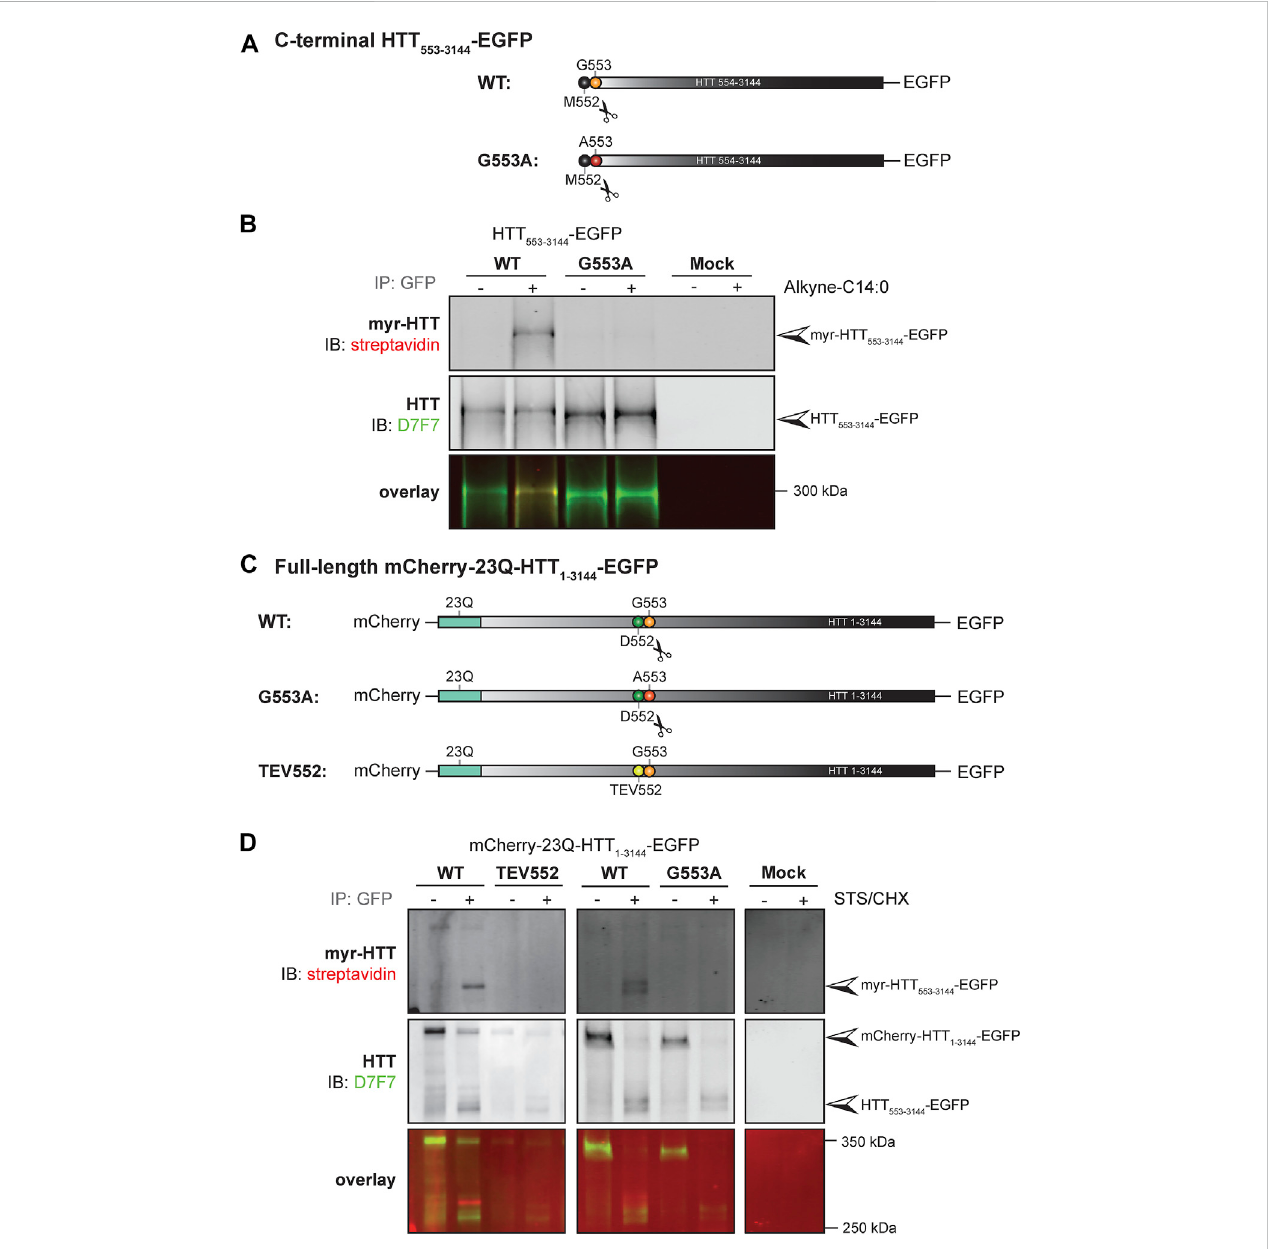
FIGURE 4 C-terminal HTT 553-3144 is co- and post-translationally myristoylated at G553 in C-terminal HTT 553-3144 and full-length HTT 1-3144 , respectively. (A) Schematicrepresentation of theC-terminal HTT 553-3144 -EGFP constructsWT or carrying a glycine 5s53 to alanine(G553A). The scissors symbol indicates the cleavage of the N-terminal methionine M552, (B) HEK293 cells transfected with C-terminal HTT 553-3144 -EGFP WT or G553A mutation were labeled with DMSOor100 µMalkyne-myristatefor4 h, (C) schematicrepresentationofthefull-lengthmCherry-23Q-HTT 1-3144 -EGFPconstructsWT,G553Aorwith the D552 caspase cleavage site replaced with a Tobacco Etch Virus proteolytic site (TEV552). The scissors symbol indicates the D552 cleavage site, (D) HeLa cells were transfected with mCherry-23Q-HTT 1-3144 -EGFP constructs WT, G553A, or TEV552. Cells were labeled with 100 µM alkyne-myristate for 30 min, and then treated for 4 h with 1 µM staurosporine (STS) and 5 μ g/mL cycloheximide (CHX) to induce proteolysis and inhibit protein synthesis, respectively. For both (B, D) , HTT fragments were immunoprecipitated from cell lysates using goat anti-GFP antibodies. The myristate analog was covalently linked to